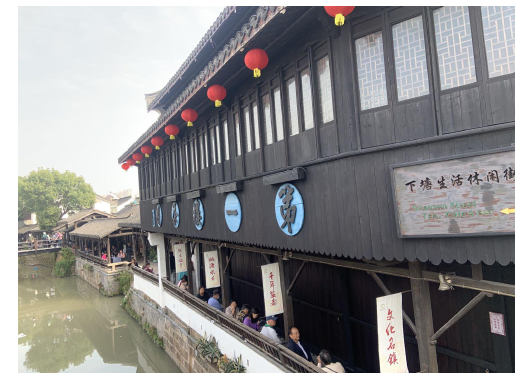
Figure 8 . The North Elevation of the Diyilou Bookstore (Photo by the author)